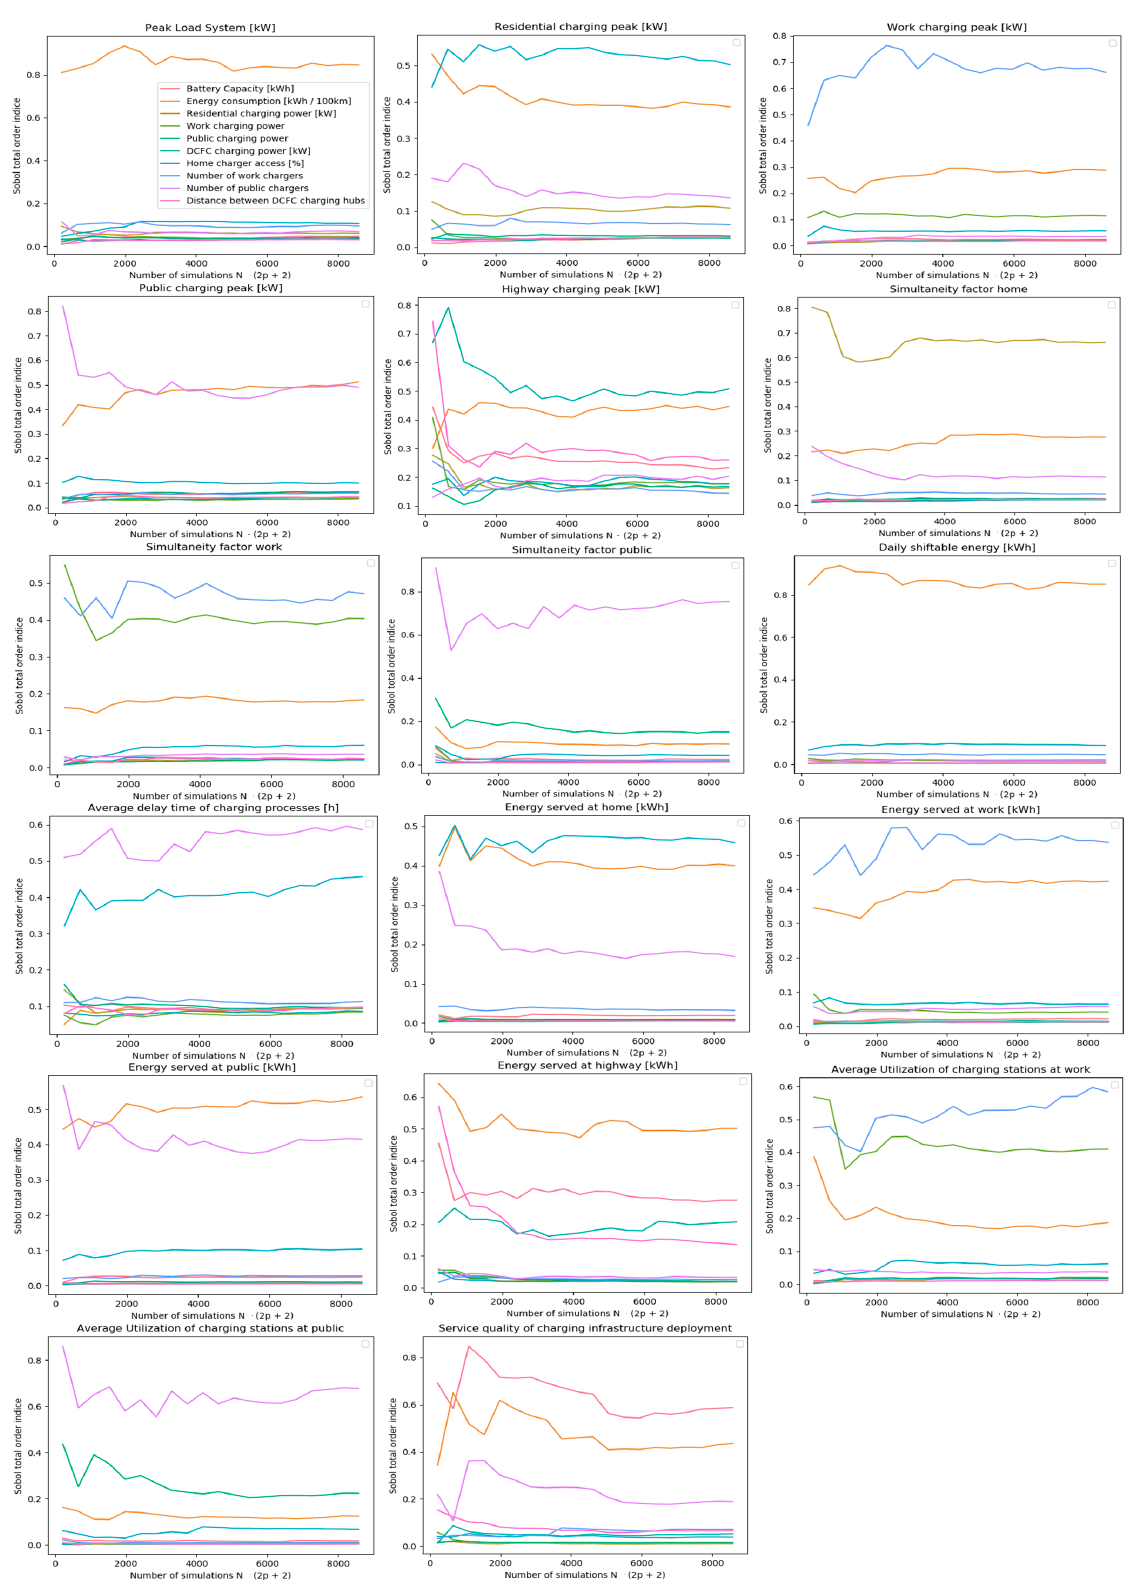
Figure A1. Sobol total order indices in dependency of the number of simulations. The number of simulations is determined by the Saltelli sampling method with N = sample size and p = number of